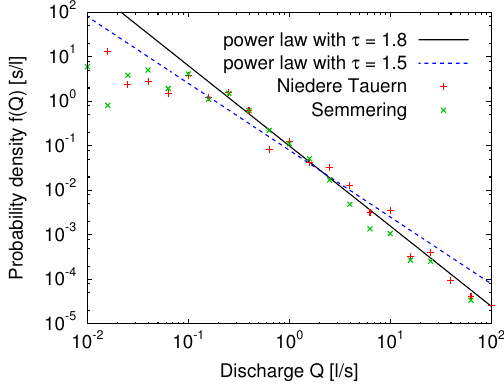
Figure 3. Probability density of the spring discharges of the two considered data sets from Austria. The estimated discrete values were obtained by logarithmic binning with five bins per